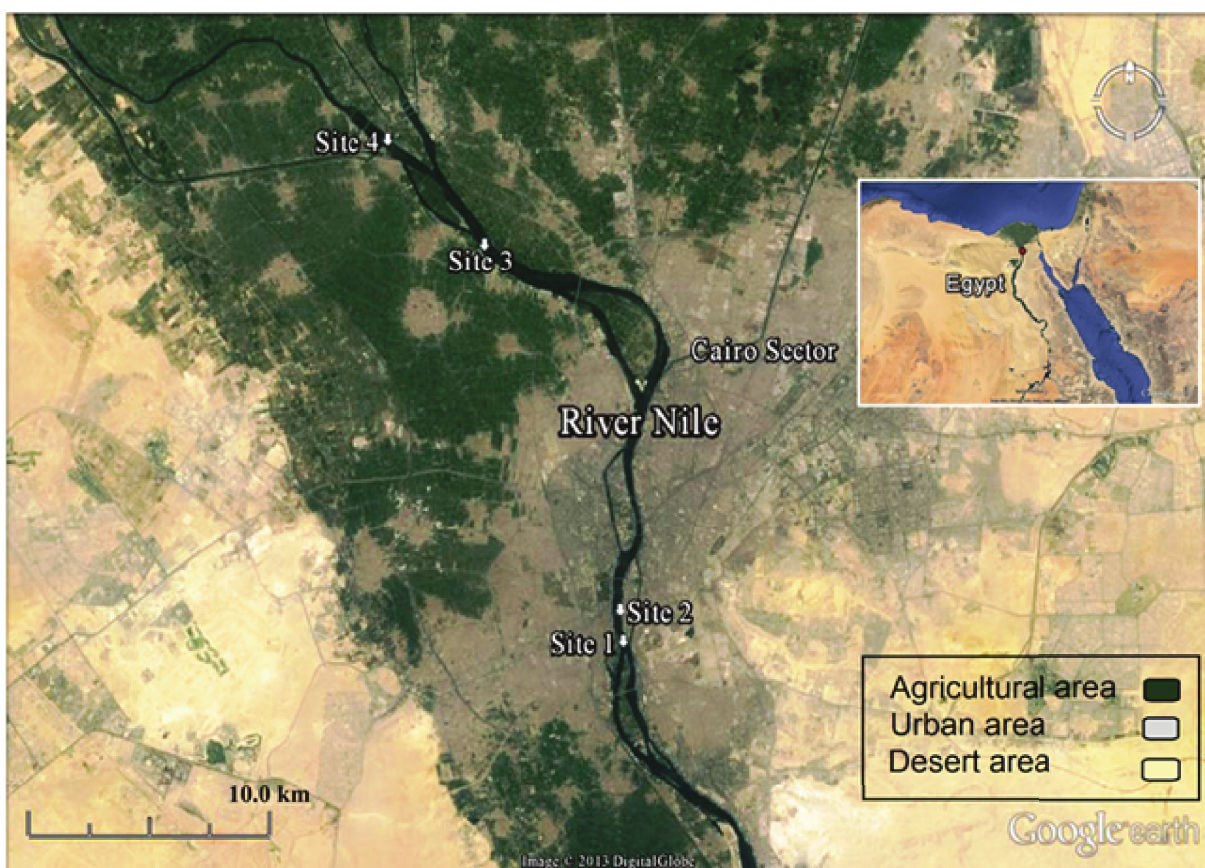
Figure 1: Map of Cairo sector showing the study sites (source: Google